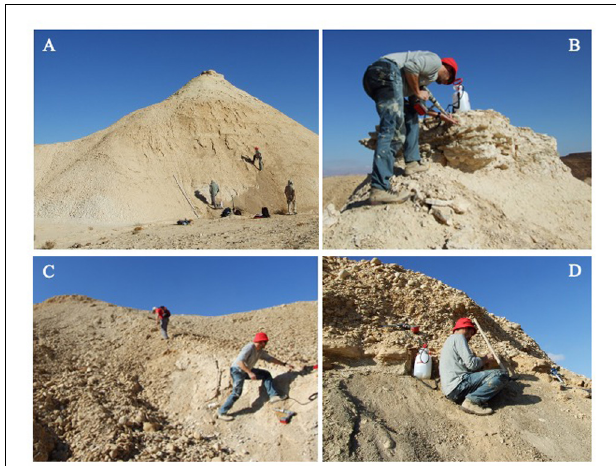
FIGURE 4 | Field pictures of the studied sediments from the Kuntila Member of the Arava Formation. (A) Overall view of the lower part of the KG section, which encompasses sediments from S1 capped by the first limestone bed of S2. (B) Detail of the lacustrine limestone. (C) View of the ochre sandstones from the middle part of S2. (D) Conglomerate of the Zehiha Formation, erosively truncating the uppermost part of